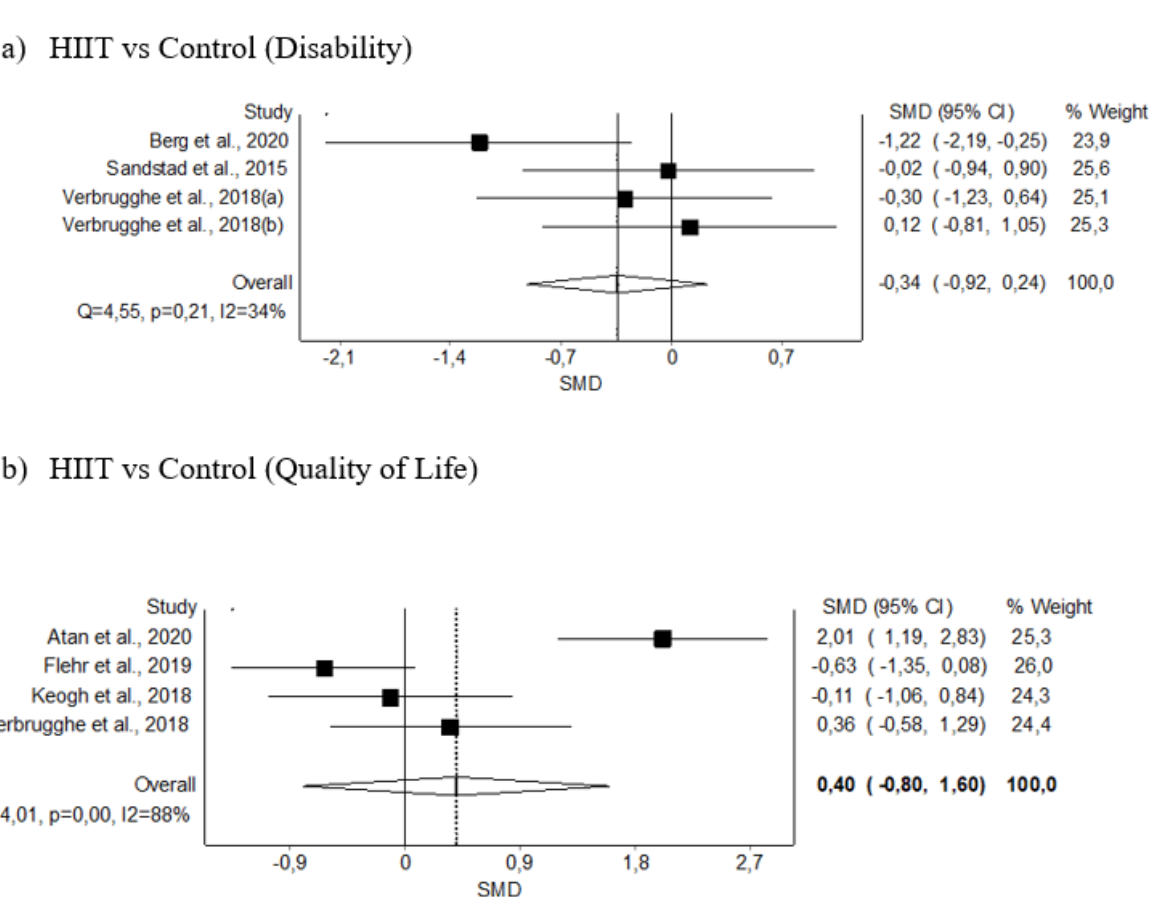
Figure 6. Synthesis forest plot of disability and quality-of-life variables. The forest plot summarises the results of the included studies (sample size, standardised mean differences [SMDs], and weight). The small boxes with the squares represent the point estimate of the effect size and sample size. The lines on either side of the box represent a 95% confidence interval (CI).